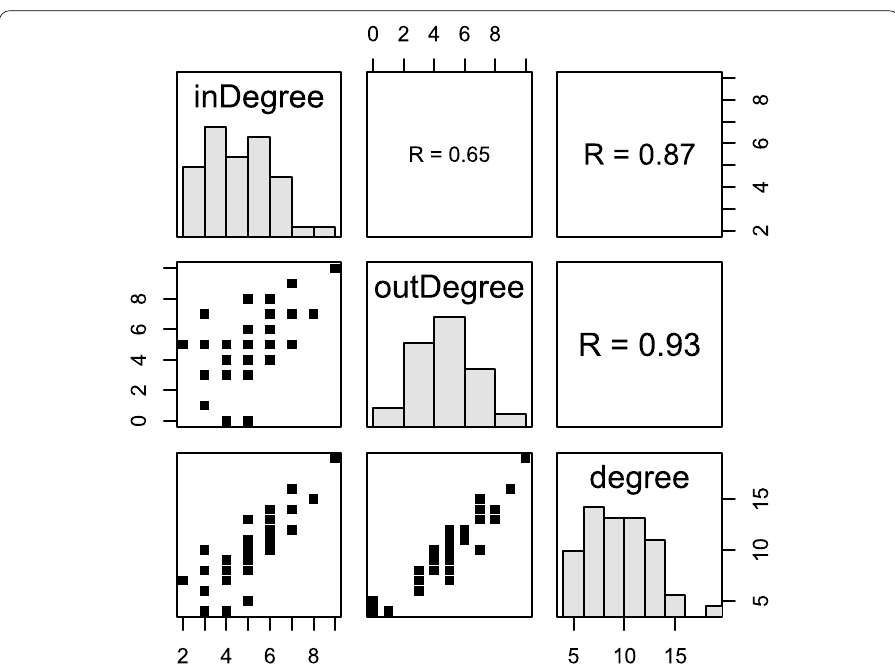
Fig. 5 Degree centrality distributions, scatterplots, and Spearman correlation coefficients for Fall 2015